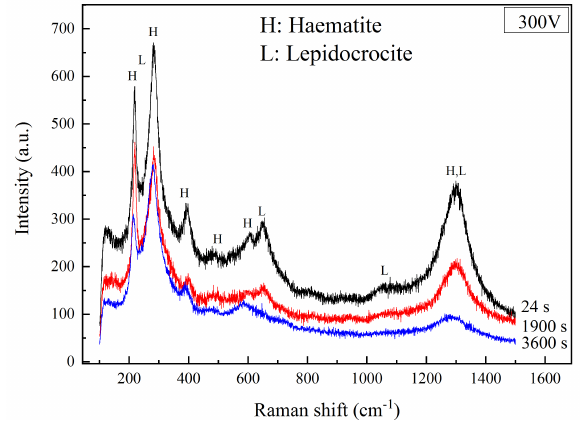
Figure 9. Raman spectra of corrosion products after 300 V HVDC interference at different